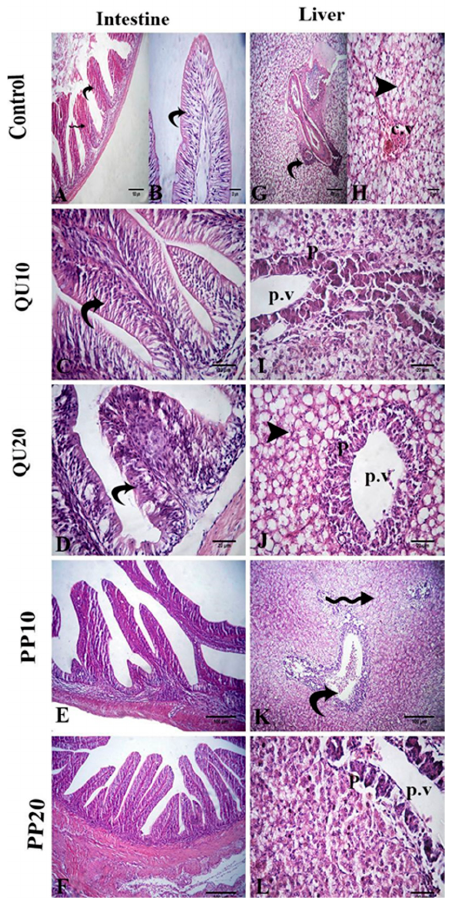
Figure 6. Photomicrographs of the H&E-stained intestinal tissue sections following the A. sobria challenge ( A – F ): A. sobria -challenged control fish ( A , B ) showing degeneration of epithelium (curved arrows), necrotized cells in the intestinal lumen (star), and hemorrhage in the submucosa (zigzag arrow). The challenged QU 10 -supplemented ( C ) and challenged QU 20 -supplemented fish ( D ) showing mild degeneration of the epithelium (curved arrows). The challenged PP 10 -supplemented ( E ) and challenged PP 20 -supplemented fish ( F ) showing normal intestinal villi. Photomicrographs of the H&E-stained liver tissue sections following the A. sobria challenge ( G – L ). A. sobria -challenged control fish ( G , H ) showing congested portal vein (curved arrow), congested central vein (cv), and fatty change (arrowhead). The challenged QU 10 -supplemented fish ( I ) showing mild necrosis of hepatocytes (arrow). The challenged QU 20 -supplemented fish ( J ) showing fatty change (arrowhead). The challenged PP 10 -supplemented fish ( K ) showing congested portal vein (curved arrow) and mild vacuolation of the hepatocytes (zigzag arrow). The challenged PP 20 -supplemented fish ( L ) showing mild necrosis of pancreatic acini